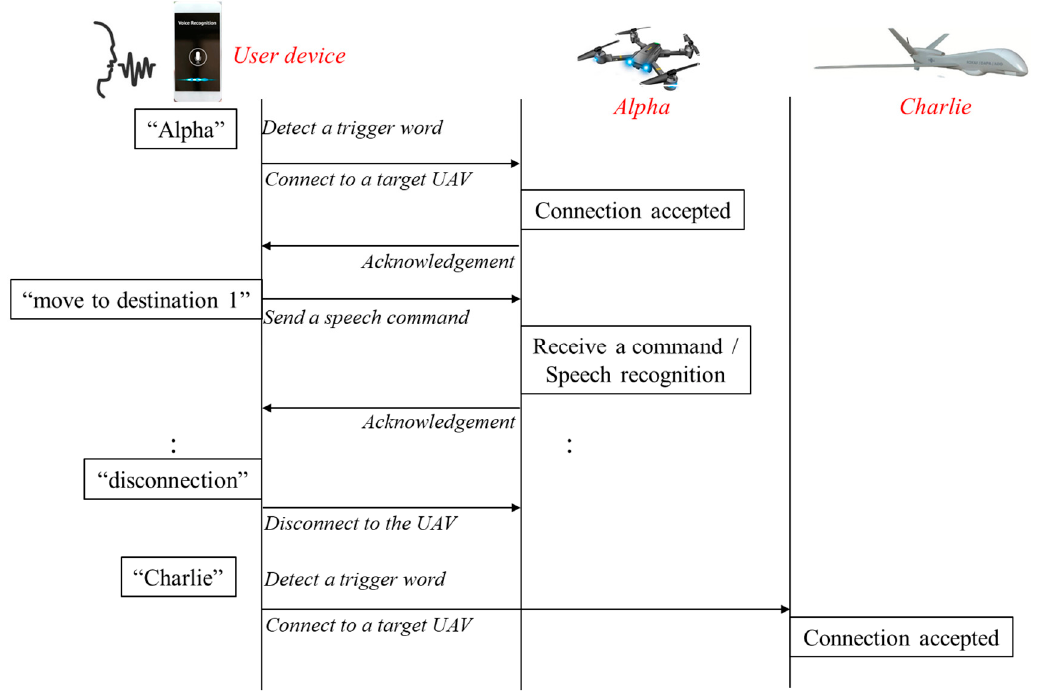
Figure A3. Standard voice interface operation in smart devices [30].